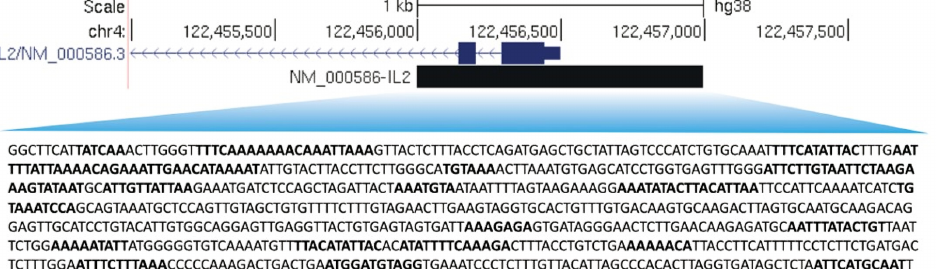
Figure 4. AT-rich motifs in the promoter region of interleukin-2 ( IL-2 ). Representative image of AT-rich enriched motifs in the promoter region of IL-2 , where the promoter region is shown in blue and the AT-rich motifs of IL-2 are shown in bold.